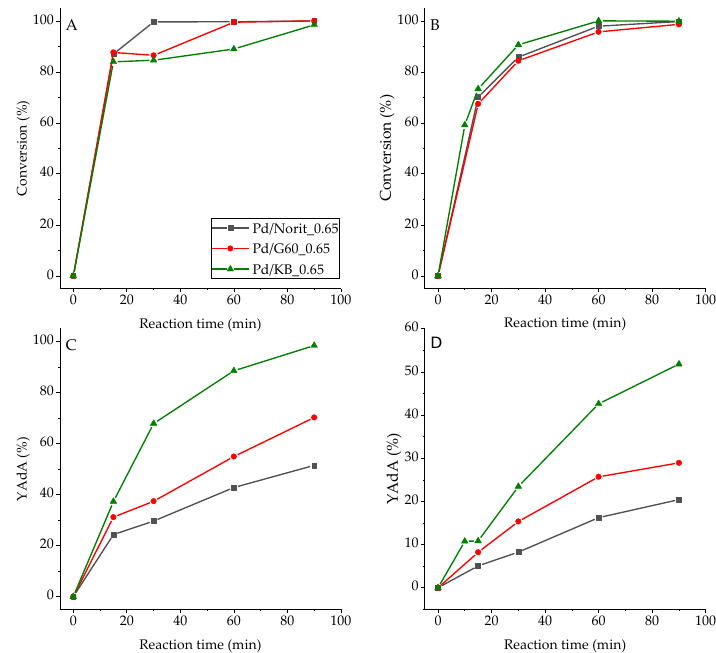
Figure 3. ( A ) The t,t-MA and ( B ) Na-Muc conversion, ( C ) and ( D ) AdA yield (YAdA) from t,t-MA and Na-Muc hydrogenation, respectively.